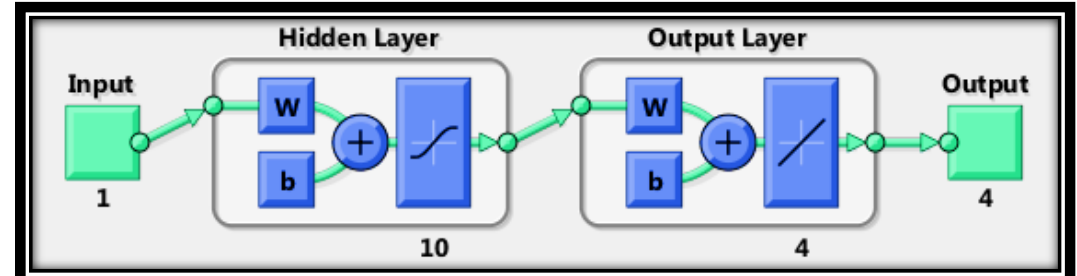
Figure 2. The Neural Network for MHD-SGFM. Table 1. Variants of MHD-SGFM.